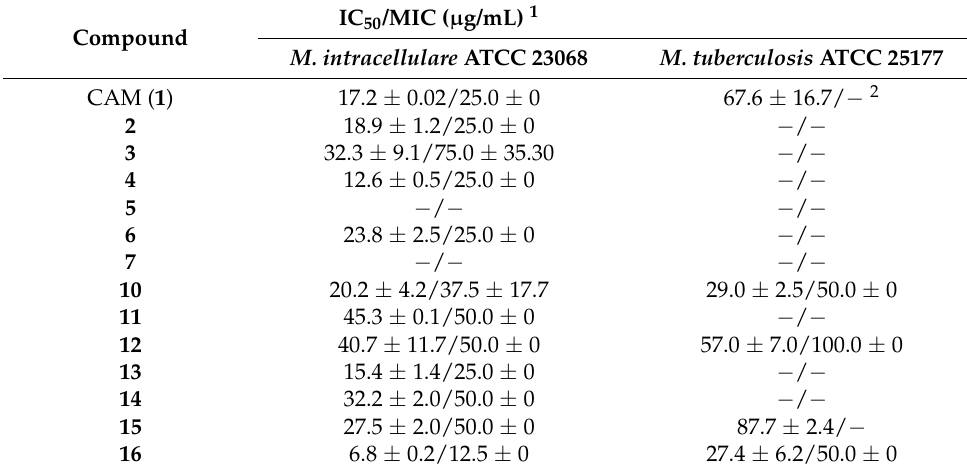
Table 1. Antibacterial activity of compounds 1 – 7 and 10 – 16